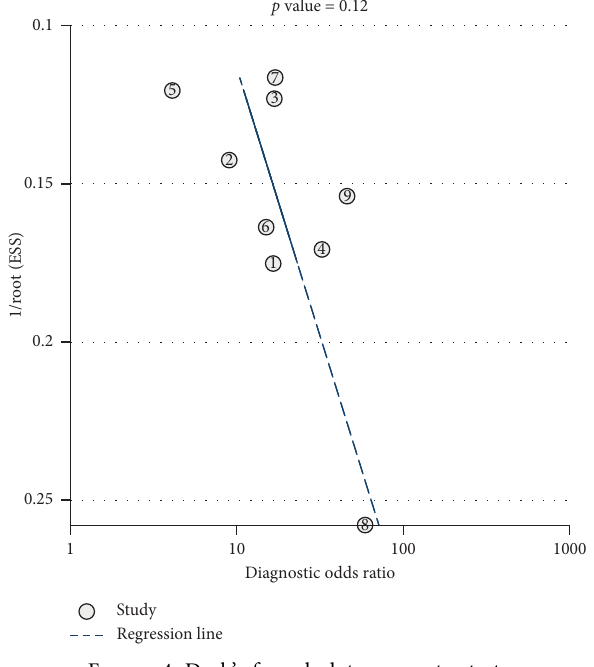
Figure 4: Deek’s funnel plot asymmetry